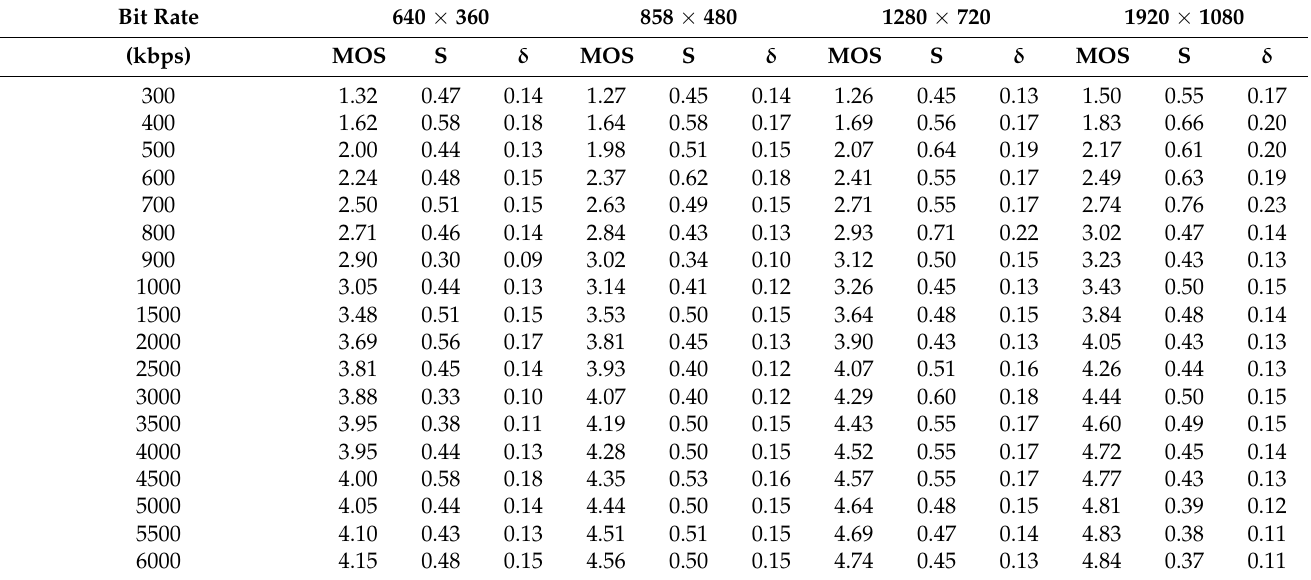
Table 8. Mean value of the video quality assessment (MOS) for VP9 codec, standard deviation (S), and confidence interval coefficient ( δ ) for four resolutions—measurements in laboratory.